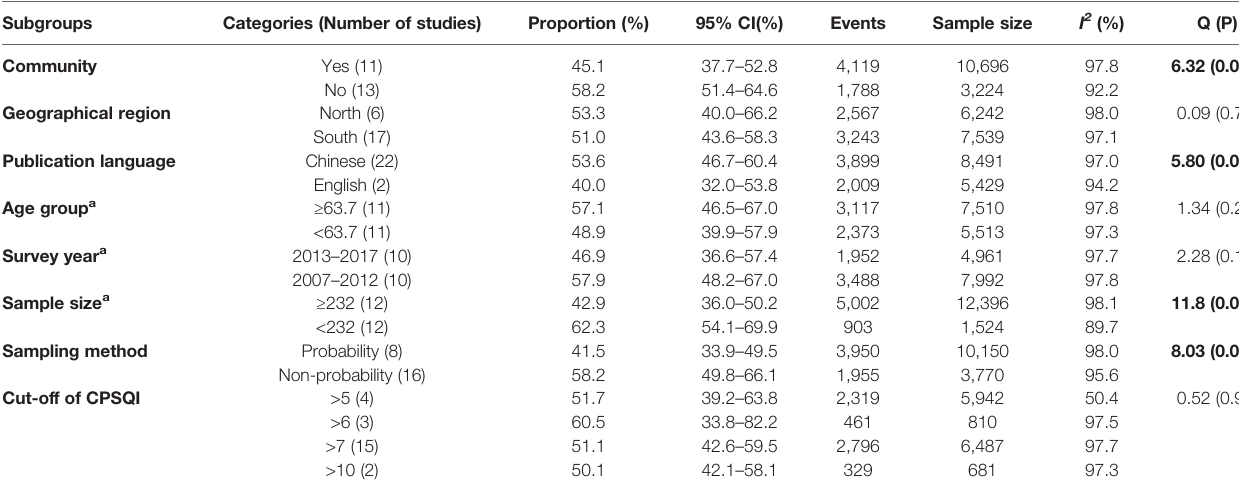
FIGURE 2 | Forest plot of prevalence of poor sleep quality in hypertensive patients. TABLE 2 | Subgroup